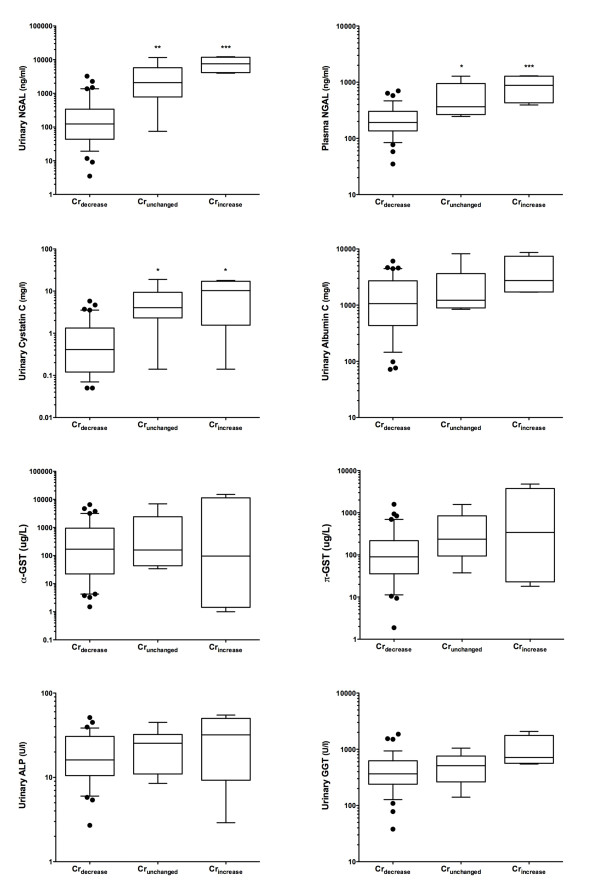
Kidney injury biomarkers associated with Crincrease and Crunchanged groups. Urinary and plasma neutrophil gelatinase-associated lipocalin (NGAL) (P < 0.0001) and urinary cystatin C (P = 0.0017) showed an increasing trend, and both Crunchanged and Crincrease were significantly different from Crdecrease (*P < 0.05, **P < 0.01, ***P < 0.001, Tukey's multiple comparison test). Apparent trends in urinary albumin, gamma-glutamyltranspeptidase (GGT), and π-glutahione-S-transferase (π-GST), the other biomarkers, were at a P value of greater than 0.05. Whiskers are at 10th and 90th percentiles. Crincrease, group of patients with a plasma creatinine increase of more than 20% at 24 hours after cardiac arrest; Crunchanged, group of patients in whom plasma creatinine increased no more than 20% or decreased no more than 10% at 24 hours after cardiac arrest.